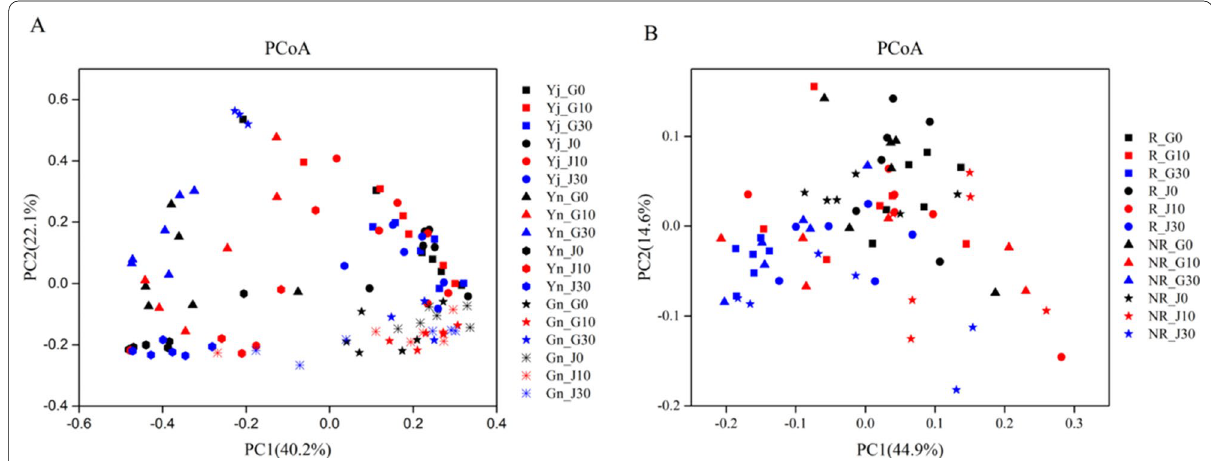
Fig. 5 Principal coordinate analysis (PCoA) of bacteria communities in plants ( A ) and soils ( B )